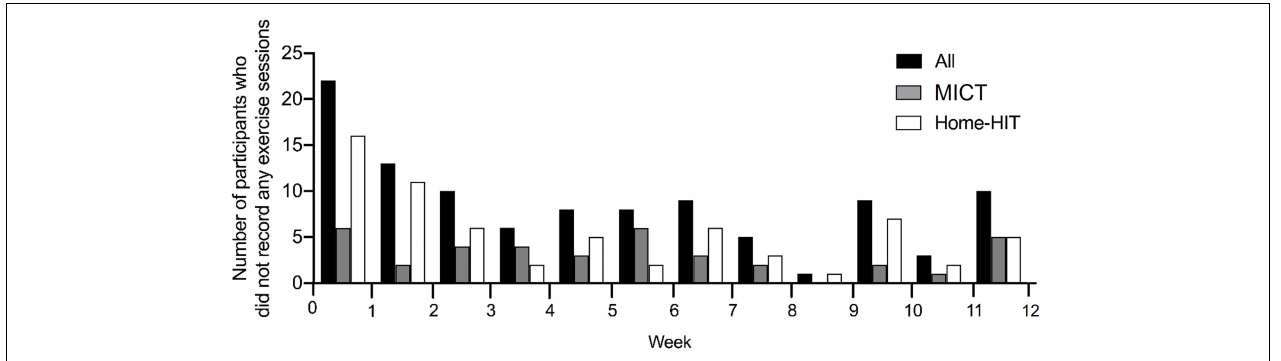
FIGURE 2 | Training drop-off over the 12-week intervention